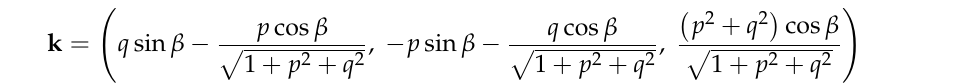
, as shown in x (cid:48) y (cid:48)